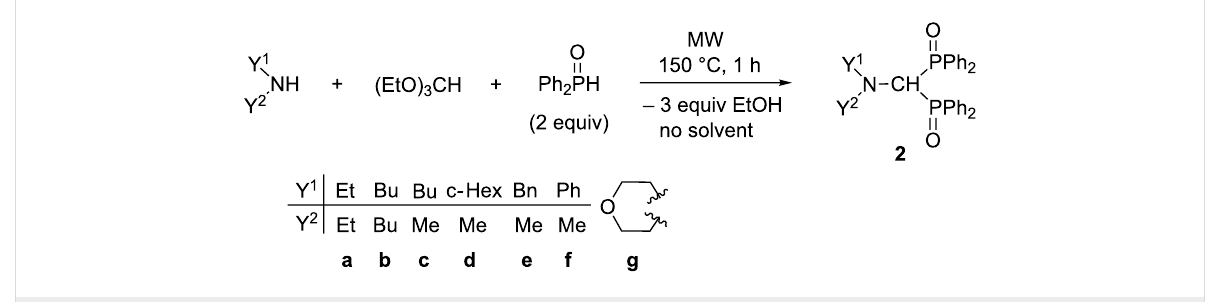
Scheme 6: Synthesis of (dialkylaminomethylene)bisphosphine